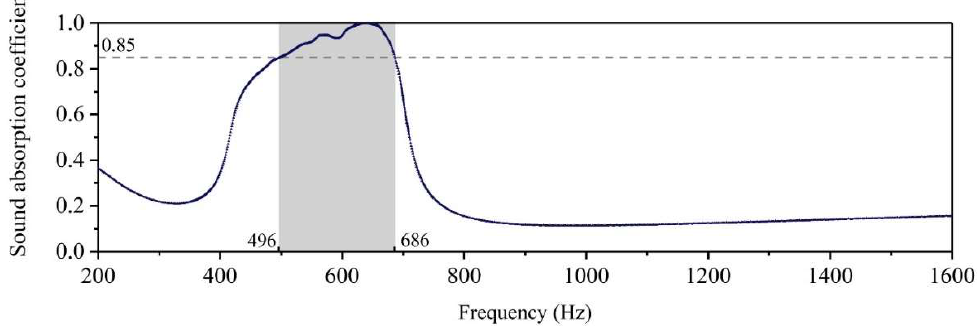
Figure 3. Sound absorption coefficient of the initial structure gained by finite element simulation. The gray area represents the frequency range that meets the design requirements.